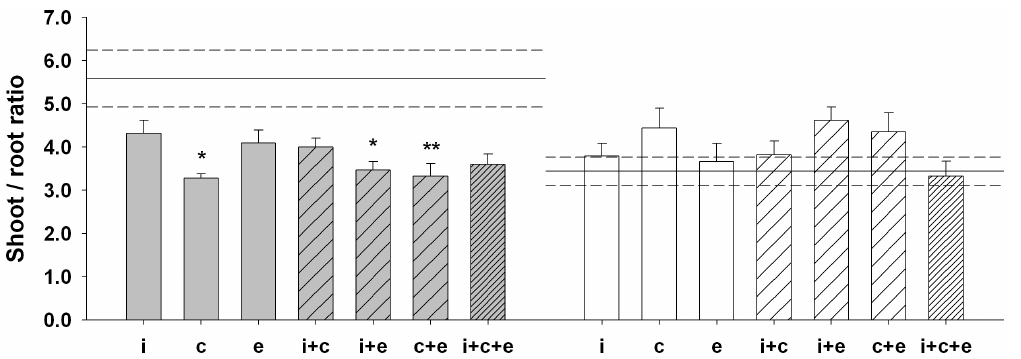
Figure 2. Effect of different AMF assemblages on the shoot to root ratio of L.vulgare . Each grey and white bar represents the treatment mean 6 1 SE either in absence or presence of R. solani , respectively. Open, lighter and heavier diagonal patterns correspond to: single (i.e., i – R. intraradices /c – R. clarus /e - C. etunicatum ), dual or tri isolate assemblages, respectively. Horizontal solid and dashed lines correspond to the control mean 6 1 SE, respectively. Those over the grey bars correspond to the negative control whereas those over the white bars correspond to the pathogen only (i.e., R. solani alone) control. Asterisks represent significant differences to the control calculated by Tukey’s HSD (* p , 0.05, ** p , 0.01, *** p , 0.001).